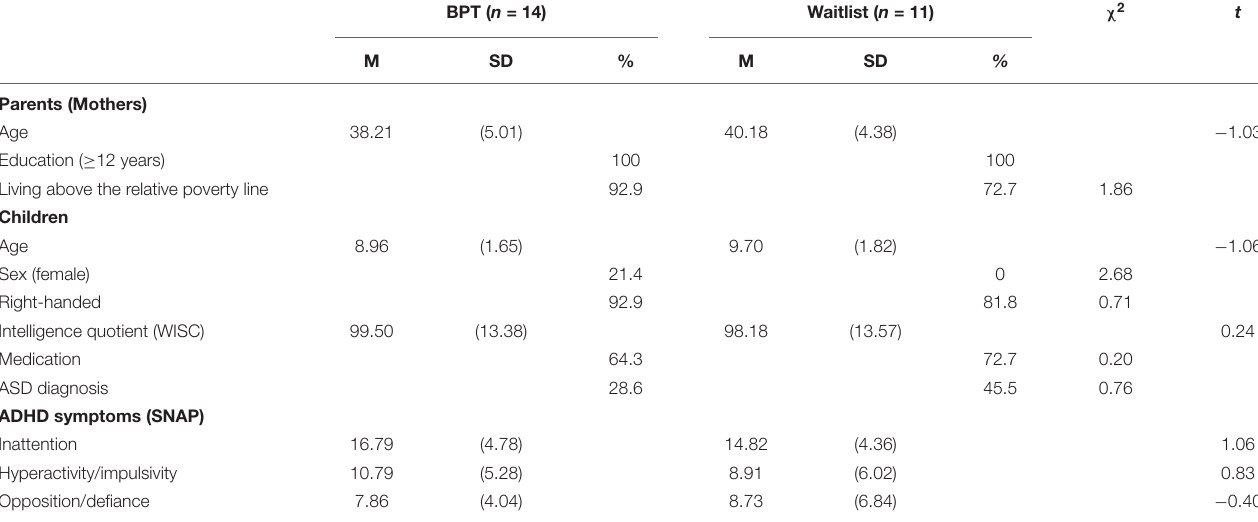
TABLE 1 | Participant characteristics.